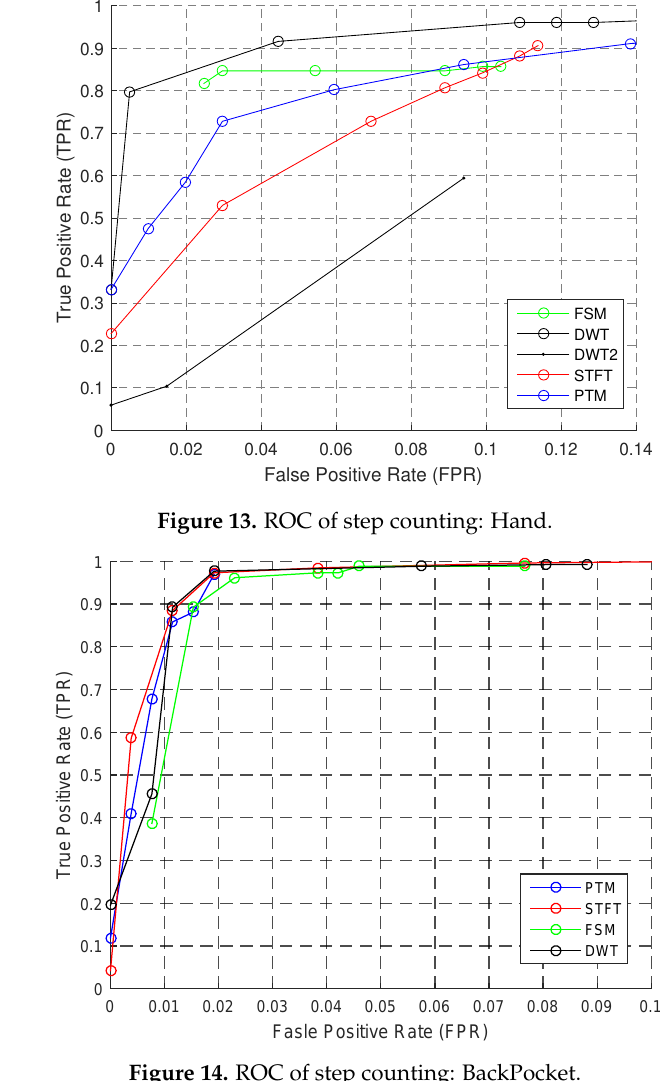
Figure 14. ROC of step counting: BackPocket.